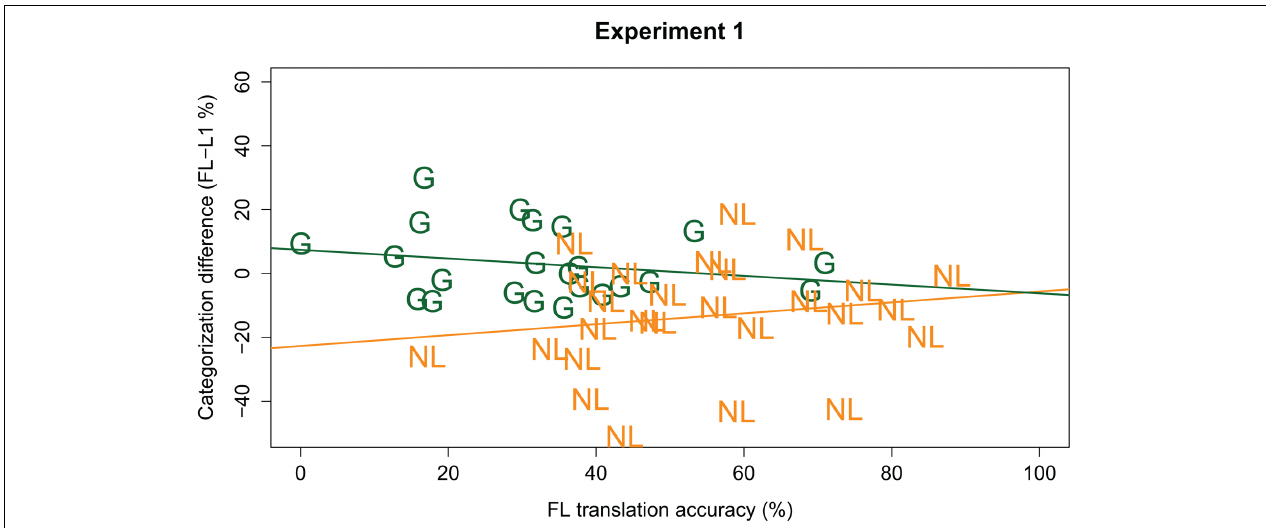
FIGURE 2 | Individual participants’ foreign language (FL) effect (y-axis; calculated as % /a:/ responses in FL minus L1; positive values indicate a higher percentage /a:/ responses in the FL) plotted against individual participants’ translation accuracy (x-axis; in % keywords correct) in the FL. German participants are indicated by green “G”; Dutch participants by orange “NL.” The green line gives the regression line for the German group; the orange line gives the regression line for the Dutch